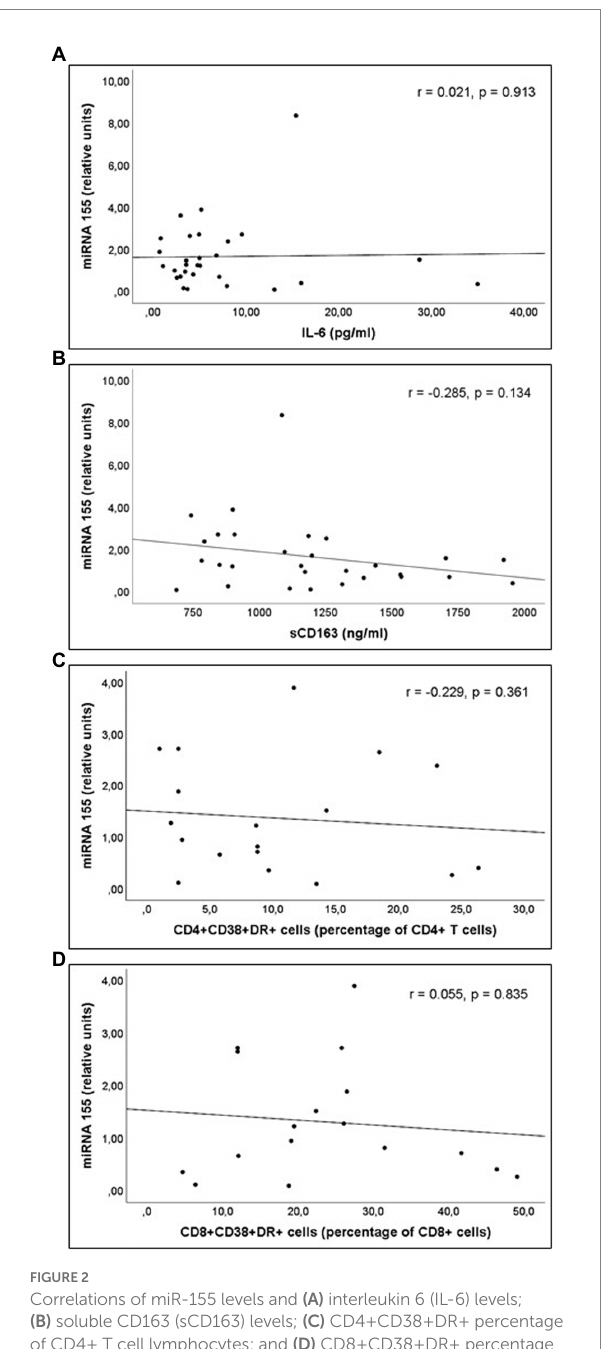
FIGURE 2 Correlations of miR-155 levels and (A) interleukin 6 (IL-6) levels; (B) soluble CD163 (sCD163) levels; (C) CD4+CD38+DR+ percentage of CD4+ T cell lymphocytes; and (D) CD8+CD38+DR+ percentage of CD8+ T cell lymphocytes count, in untreated people living with HIV.